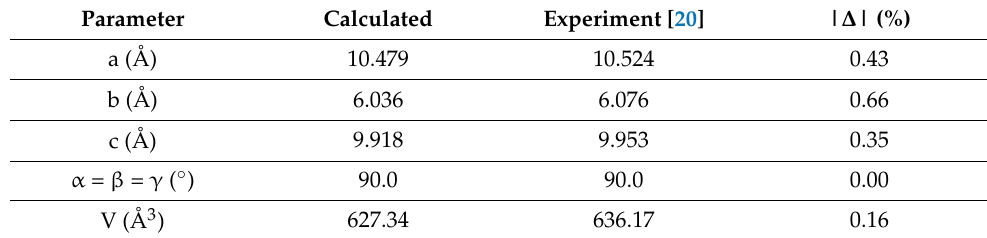
Figure 1. ( a ) Crystal structure, ( b ) total DOS plot, and ( c ) charge density plot showing the bonding interaction between ions in Li 6 SiO 4 Cl 2 . Table 1. Calculated and experimental parameters of Li 6 SiO 4 Cl 2 . Parameter